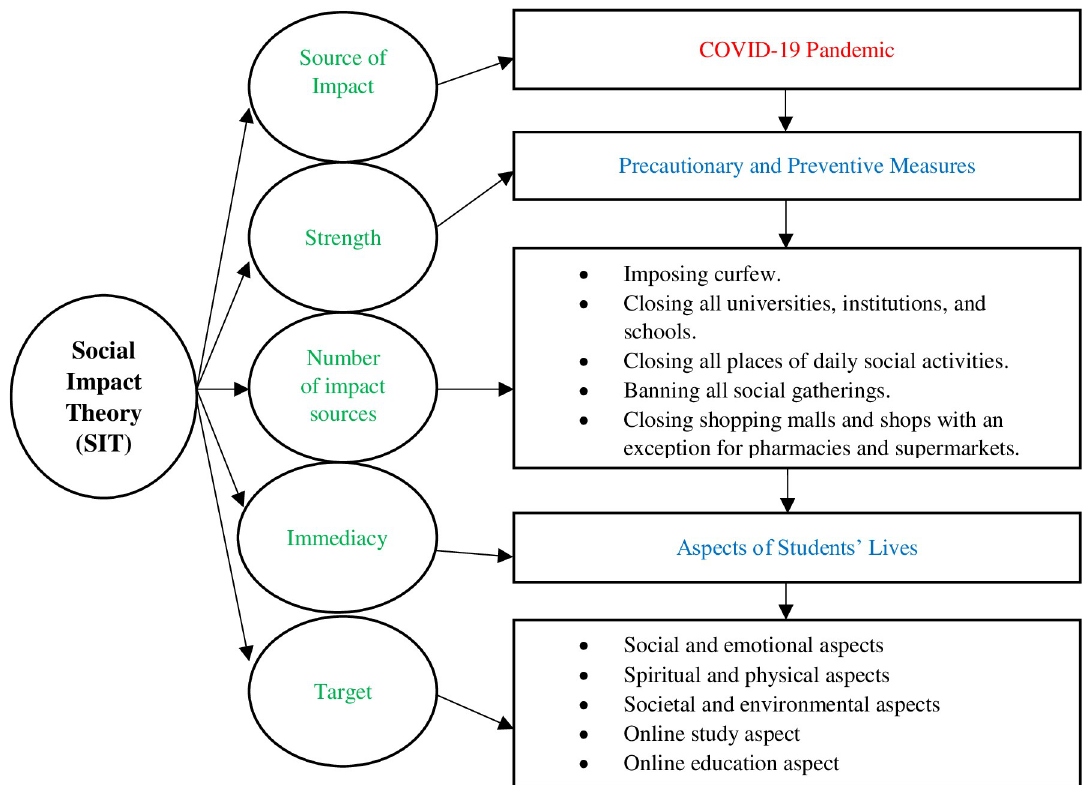
Fig 1. Framework of SIT for the impacts of the COVID-19 pandemic on students’ lives.